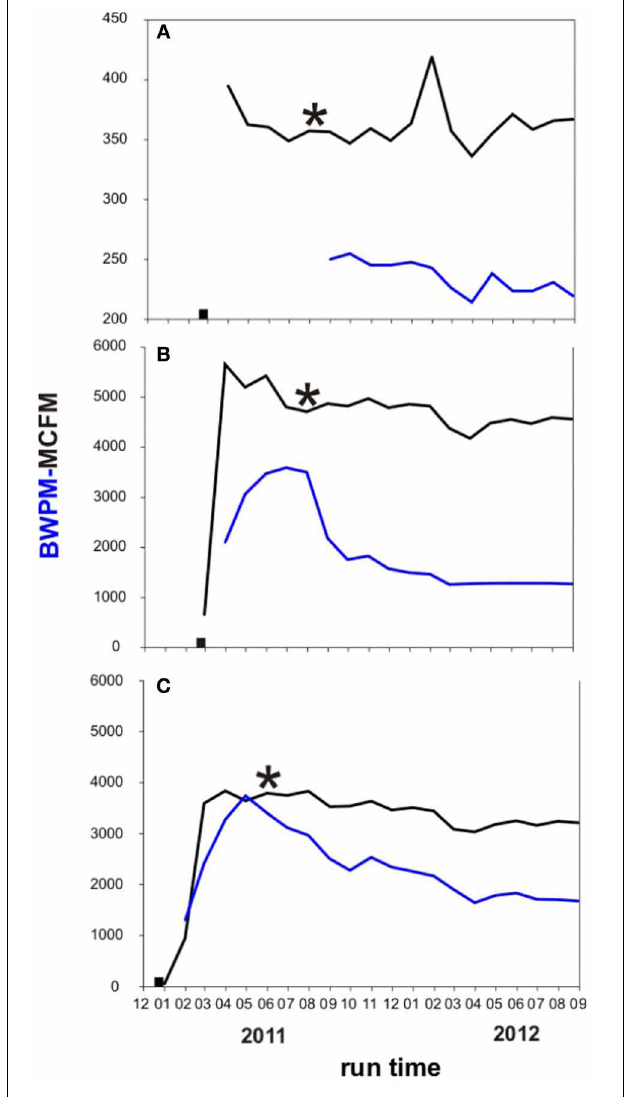
FIGURE 2 | Monthly water and gas production in the three investigated wells. Black: Thousand cubic feet gas per month (MCFM). Blue: barrels of water per month (BWPM). Black square: time when well was fractured. Black asterisk: time when formation water was sampled